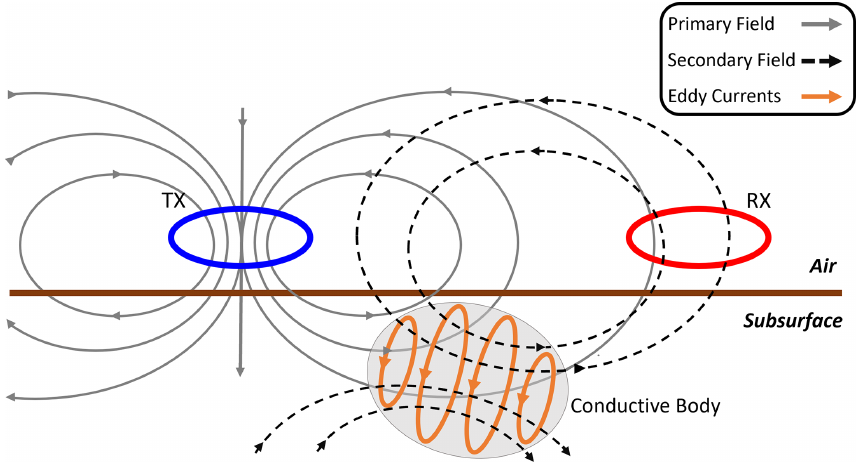
Figure 1. The magnetic fields resulting from a horizontal coplanar T x - R x system configuration over a conductive body. The T x electronics produce a time-varying current in the T x coil (blue ring), which generates an alternating magnetic field (solid gray line) that is present in the air and subsurface. This field will generate eddy currents in conductive subsurface material (orange lines) that create a secondary magnetic field (black dashed lines). The R x unit (red ring) measures the combined effects of the time-varying primary and secondary magnetic fields as a